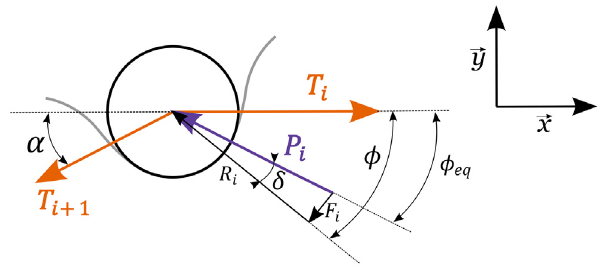
Fig. A1. Articulation equilibrium with ~ x and ~ y